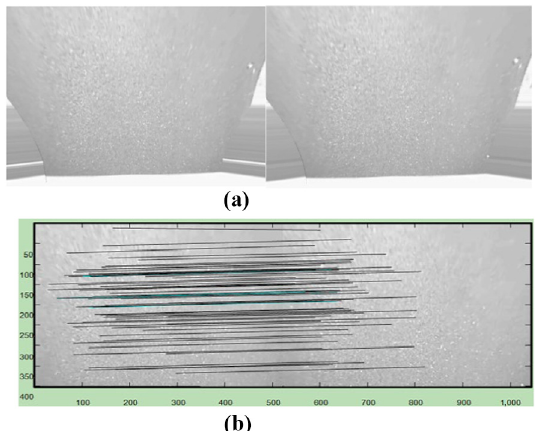
Figure 10 (a) The preprocessing results for 42-th and 43-th frame images; and (b) the matching results based on the improved SURF algorithm